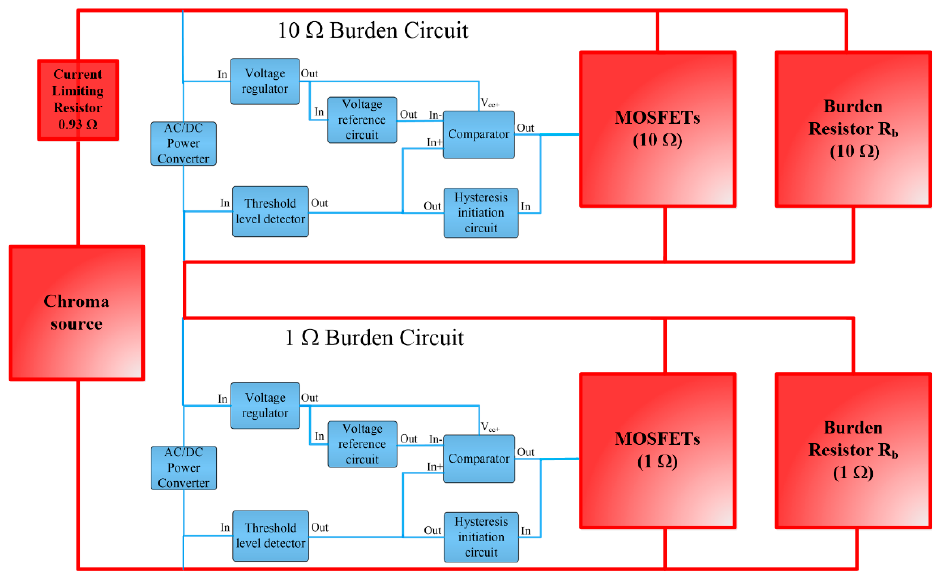
Figure 13. Block diagram of the secondary current injection test setup for the autoranging circuit.